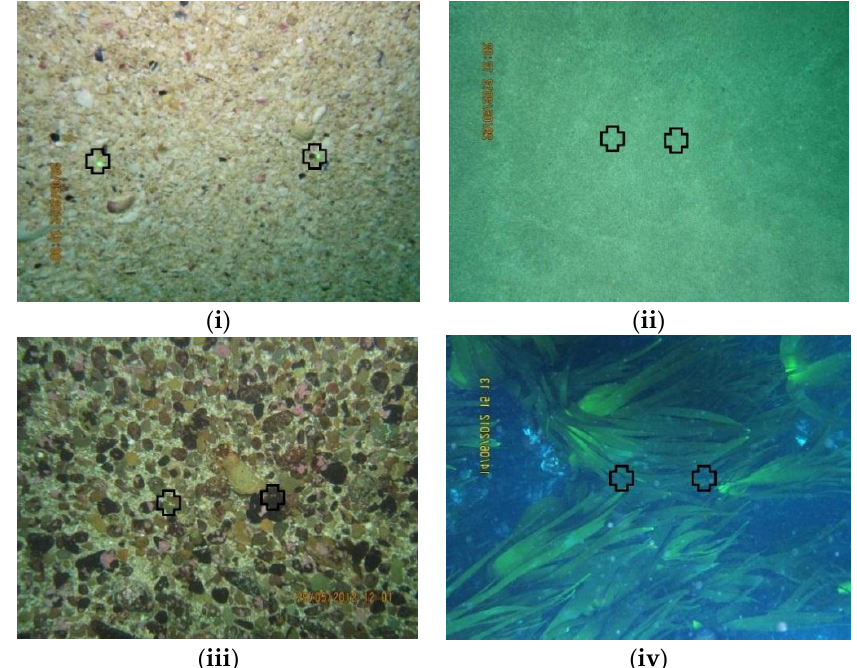
Figure 9. ROV images showing shell material from the wedge shaped sediment bank ( i ) and medium grained mineral sand from the oval shaped bank in the north of the study area ( ii ); Cobble halo surrounding oval shaped sediment bank to the north of the study area ( iii ) and kelp covered bedrock ( iv ). Markers show position of laser markers showing approximate 20 cm scale. (Laser markers only visible in high resolution image).